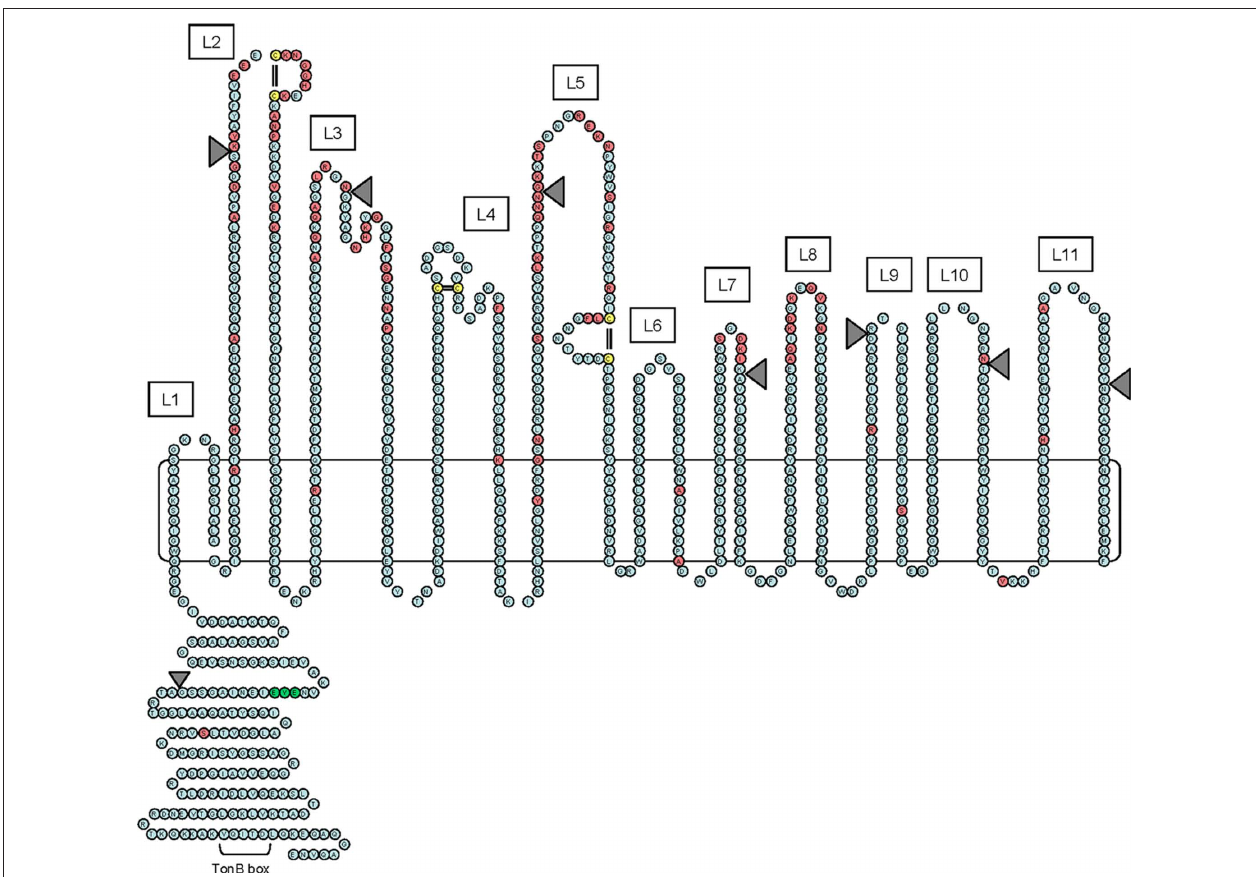
Figure 2 | Hypothetical two-dimensional topology model of gonococcal TbpA. The sequence shown is of the TbpA protein from gonococcal strain FA19. The model includes an amino-terminal plug domain of 161 residues, 11 surface-exposed loops (numbered L1–L11), and 22 transmembrane beta- strands. Residues highlighted in red are those that are divergent among a panel